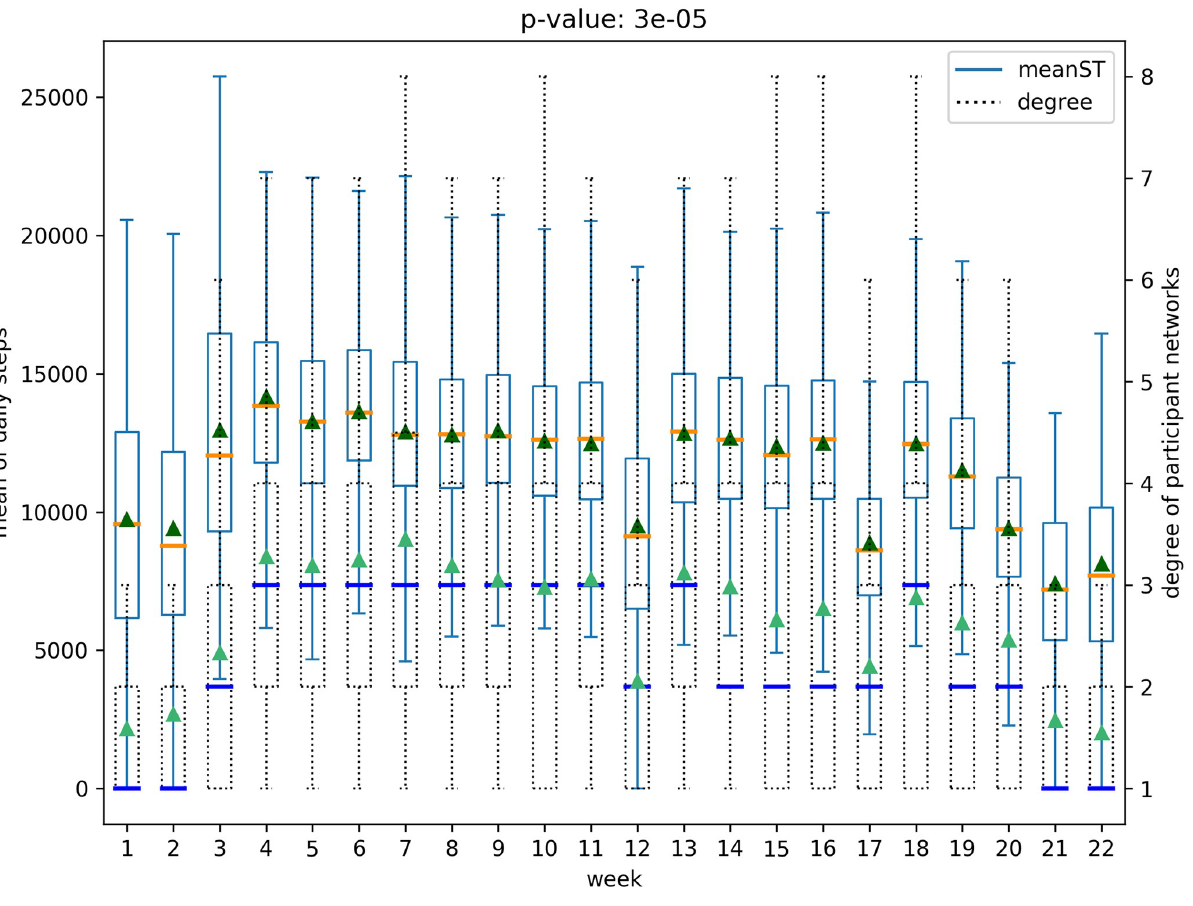
Fig 6. Relation between daily steps and degree of participant network